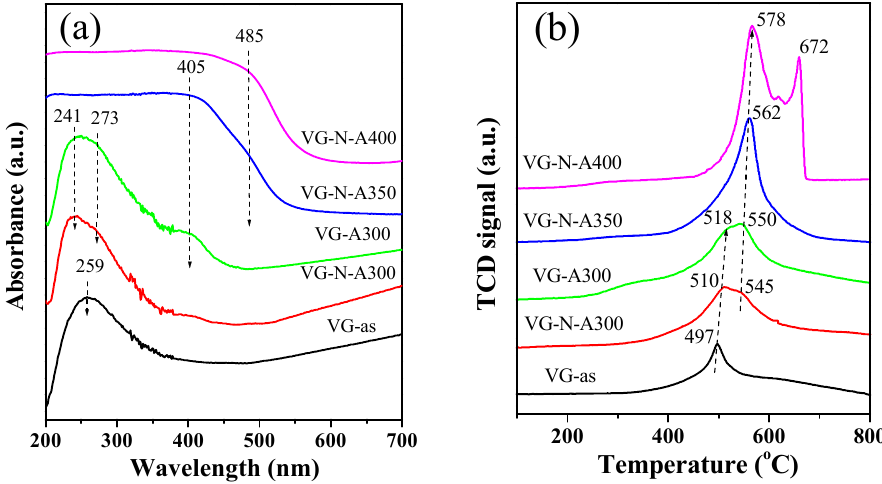
Figure 6. Ultraviolet ‐ visible diffuse reflectance spectrum (UV ‐ Vis DRS) curves ( a ) and temperature ‐ programmed reduction of hydrogen (H 2 ‐ TPR) profiles ( b ) of various VO x /RGO composites.